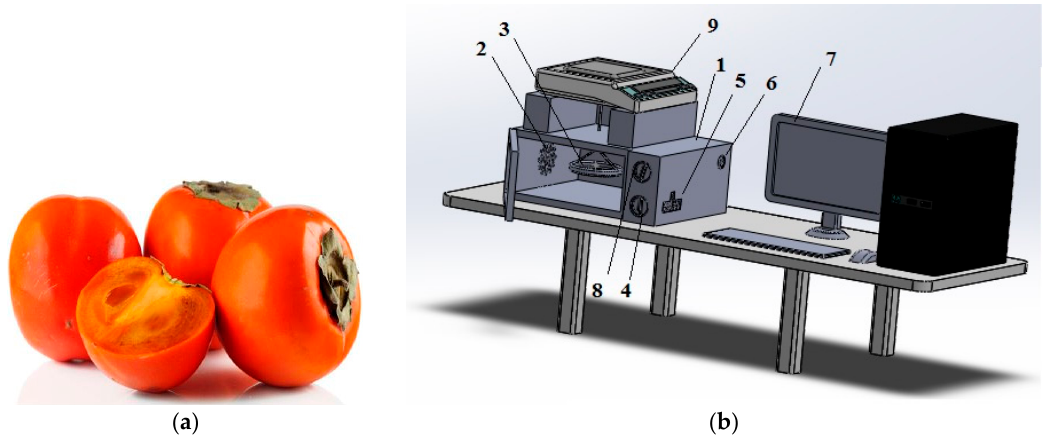
Figure 1. ( a ) Trabzon persimmon, ( b ) Microwave Drying System (1: Microwave oven, 2: Ventilation